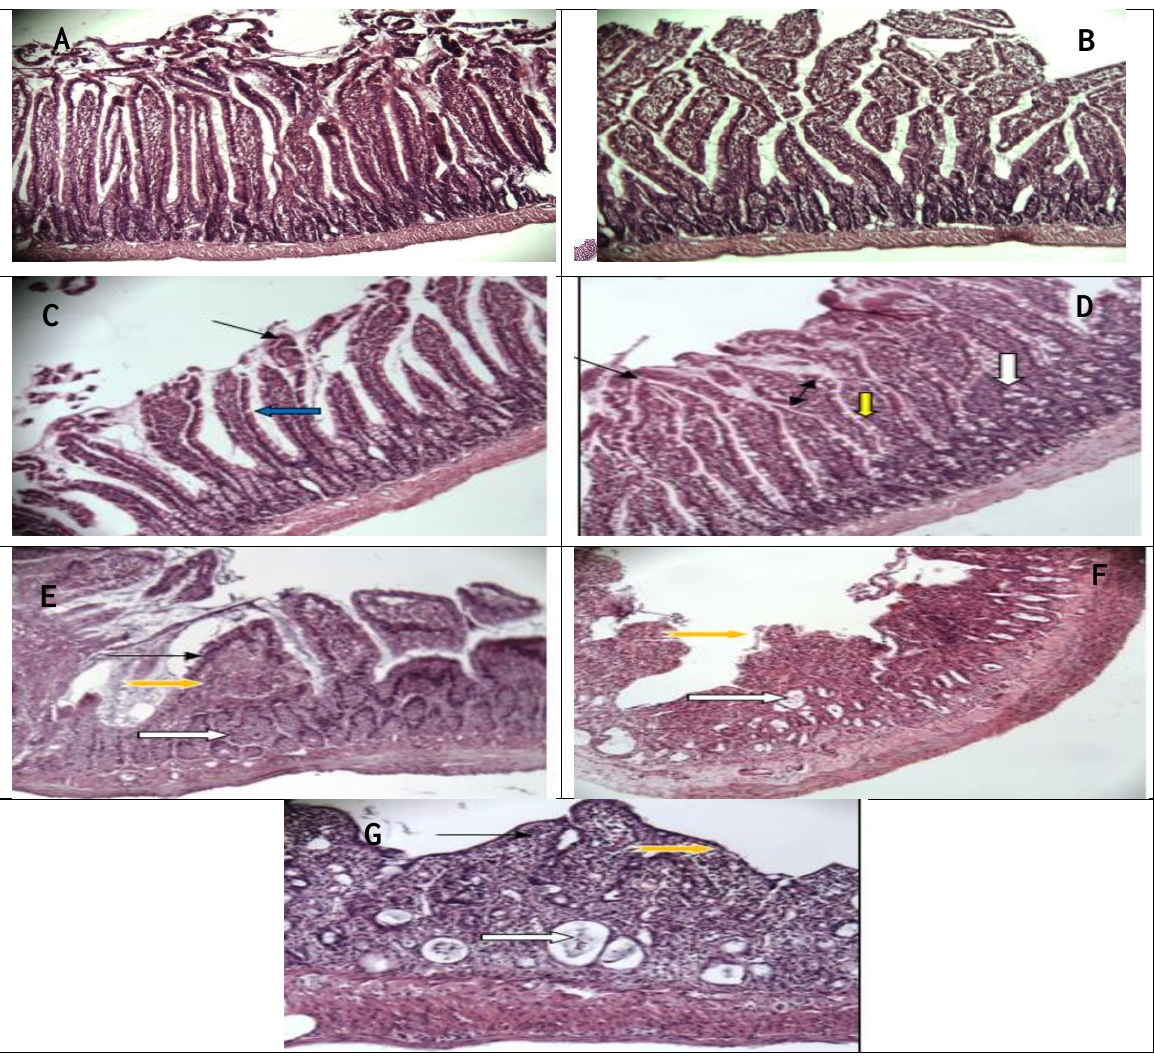
Figure 3. Sections of the jejunum tissue of various rats groups (Haematoxylin and eosin (H&E) X 10).A and B) Group I and Group II: normal appearance of villi (v) and crypts (c), no epithelial atrophy, with a mild to moderate degree of mixed inflammatory cells infiltrate is seen in lamina propria, and no goblet cell depletion. C) Group III: a mild villous, crypts damage, mild epithelial atrophy and goblet cells depletion compared to the area pointed by the large arrow which shows goblet cells. D) Group IV: focal widening ( )and shorting of villi, a mild crypt damage, a mild mixed inflammatory cells infiltrate in the lamina propria and the tips of villi showed mild goblet cell depletion compared to the sides of the villi where by goblet cells are still present. E) Group V: moderate villous and crypts damage represented by shortening, widening and fusion of villi with v/c ratio 2/1, moderate epithelial atrophy and moderate inflammation were seen in lamina propria and moderate goblet cells depletion. F) Group VI: severe damage that represented by shorting, widening and fusion of villi (villous atrophy) with v/c ratio 1/1, crypt abscess, moderate epithelial cells atrophy, a heavy mixed inflammatory cells infiltrate is also seen in lamina propria, and goblet cells depletion. G) Group VII: severe damage represented by loss, widening and fusion of villi with v/c ratio 1/1, crypt abscess, severe epithelial atrophy, heavy mixed inflammatory cells infiltrate is seen in the lamina propria and sever goblet cells depletion. Yellow arrows indicate villi damage, white arrows indicate crypt abscess, and blue arrow indicates goblet cells and black arrows indicate goblet cells depletion